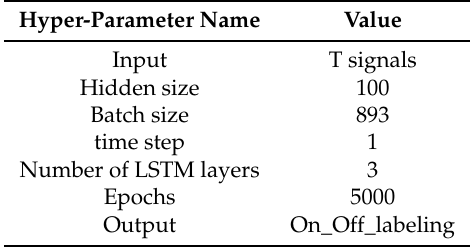
Table 9. Hyper-parameter of LSTM model in the approach.